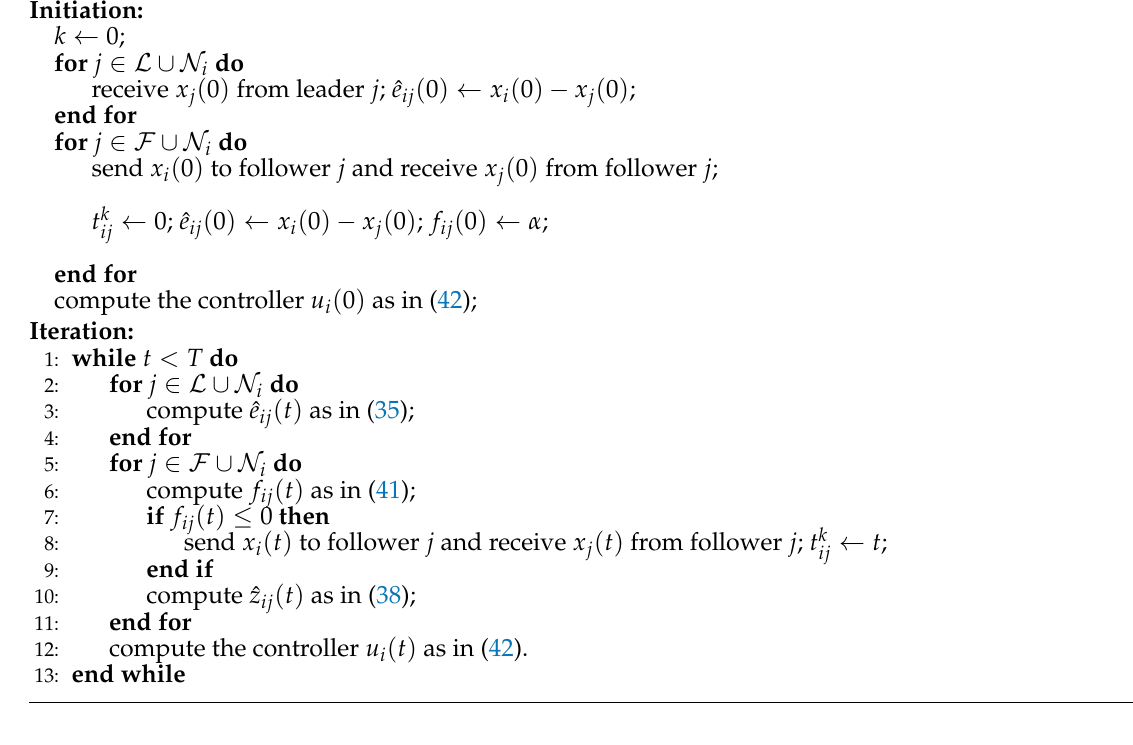
Algorithm 2 Event-Triggered Containment Control Algorithm for Agent i: with input delay.